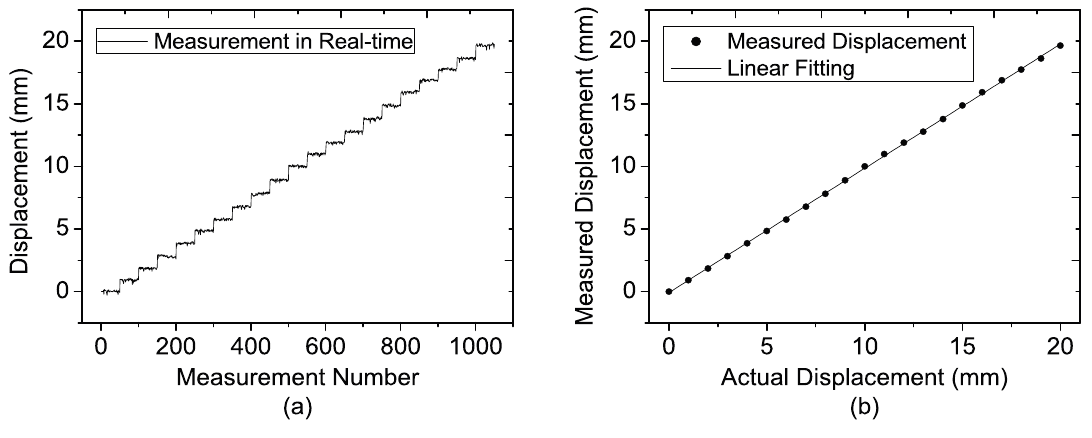
Figure 12. Measured results of the target located at the distance of 20 m at each step for ( a ) 50 single-measurement results; ( b ) Average of the 50 single-measurement results.